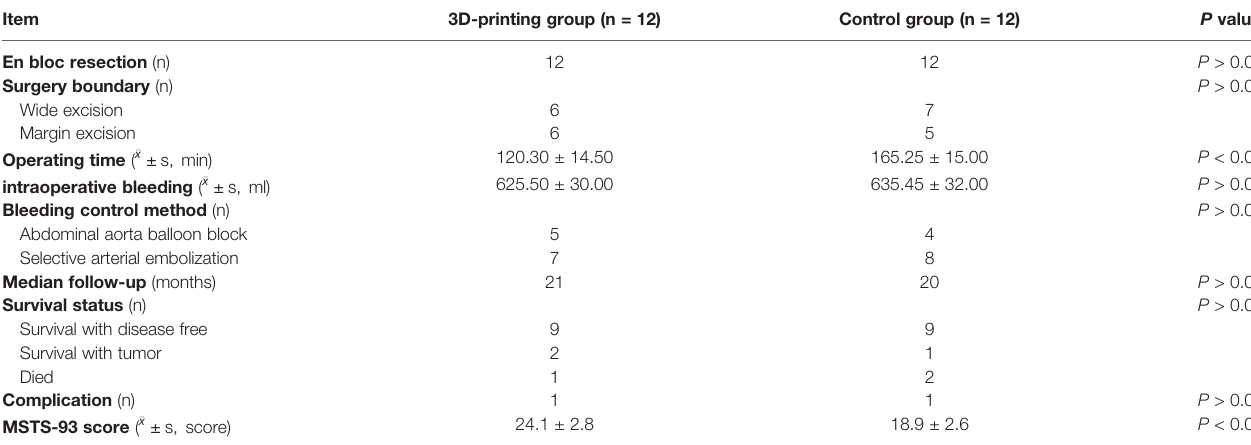
TABLE 2 | Surgical data and follow-up results of patients with sacroiliac joint tumor resection and